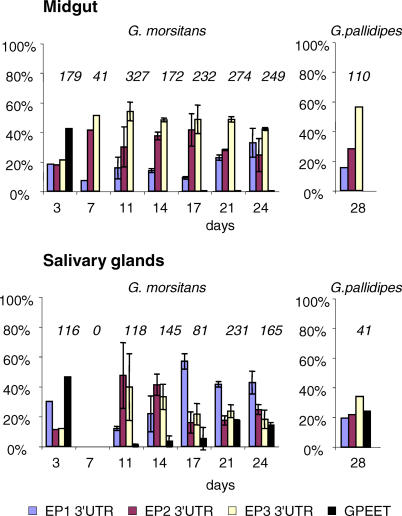
Distribution of Procyclin mRNAs Expressed by Tsetse-Derived TrypanosomesRNA was isolated from the midguts and salivary glands at various days post infection and subjected to RT-PCR using generic primers for all procyclins. The products were cloned and individual clones assigned by hybridisation with a panel of oligonucleotides (see Materials and Methods). The total number of procyclin clones analysed at each time point is indicated within the chart. The standard deviations for the data from days 11–24 derive from two independent tsetse infections.